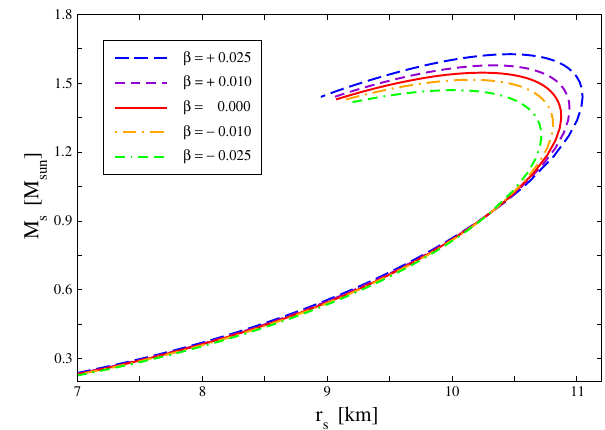
Fig. 3 Radial profile of total mass m ( r ) for different values of β ( β = 4 B ω ) with central density ρ c = 2 . 5414 × 10 15 g cm − 3 . The inset shows Fig. 4 Mass–radius relation (between stellar mass M s and stellar radius r s ) for different values of β